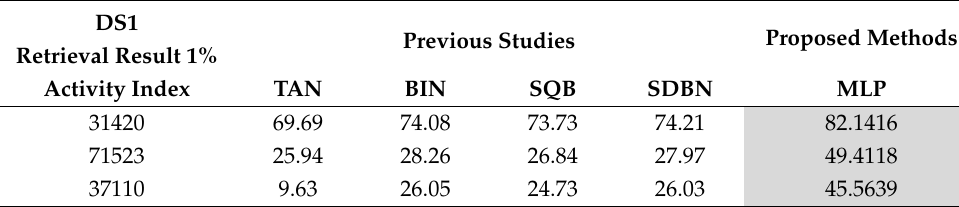
Table 6. Retrieval results of top 1% for MDDR-DS1 dataset for (ECFC_4) descriptor.